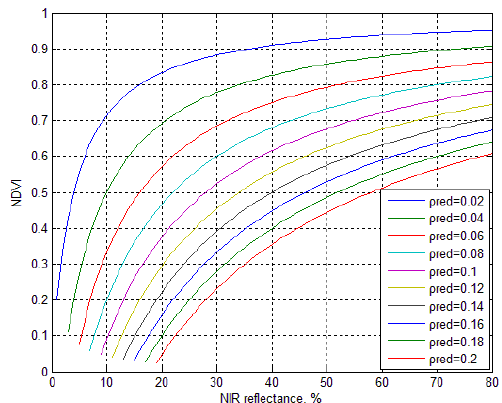
Figure 4. NDVI and NIR reflectance plot under various Red reflectance